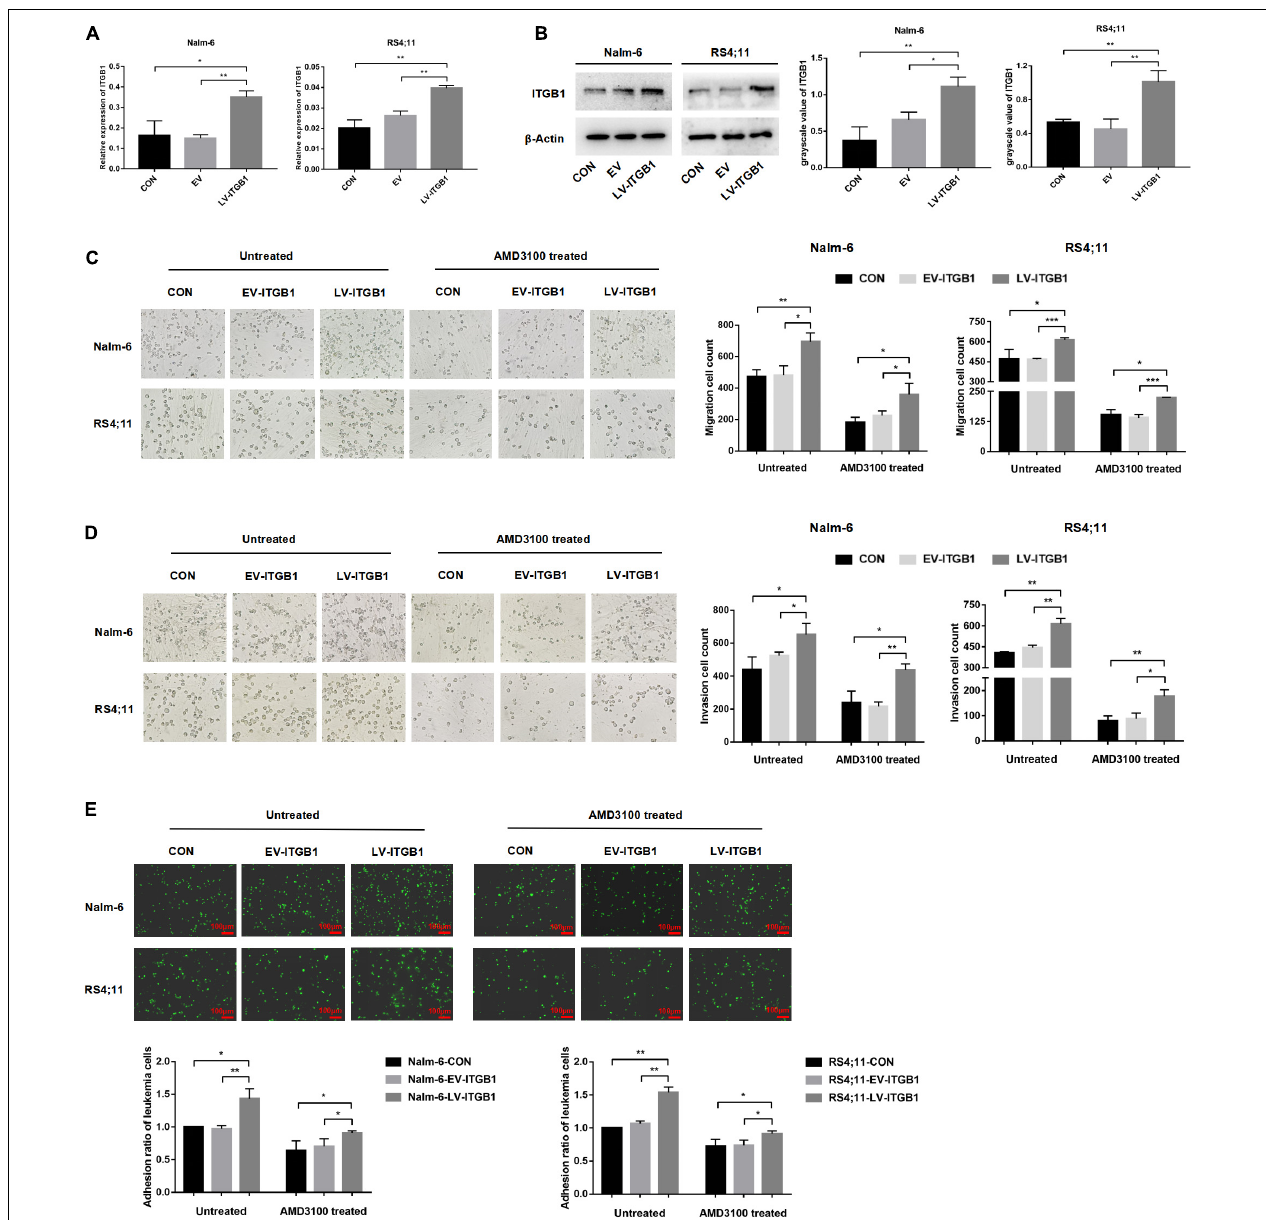
FIGURE 8 | Up-regulating the ITGB1 in leukemia cells could partially reverse the inhibition effect of AMD3100 on the interaction between leukemia cells and MSCs with CAF-like phenotype. (A,B) The mRNA and protein expression levels of ITGB1 in Nalm-6 and RS4;11 cell lines were measured by RT-PCR and western blot after transfection with EV and LV-ITGB1 recombinant lentiviral. (C,D) Transwell chamber test to detect the effect of TGF- β conditioned MSCs on the migration and invasion of Nalm-6 and RS4;11 cells in the control group, the EV group, and the LV-ITGB1 group, as well as the changes in the migration and invasion of the above groups after AMD3100 (50 µ M) treating (cultured for 24 h). (E) Fluorescence quantitative method detected the adhesion of leukemia cells to stromal cells when TGF- β conditioned MSCs were co-cultured with control group of leukemia cells, EV group of leukemia cells and LV-ITGB1 group of leukemia cells for 24 h, respectively. As well as the changes in the adhesion of the above groups after AMD3100 (50 µ M) treating (100 × , scale bars, 100 µ m). Each value indicates the mean ± SD of three independent experiments. * P < 0.05, ** P < 0.01, *** P <